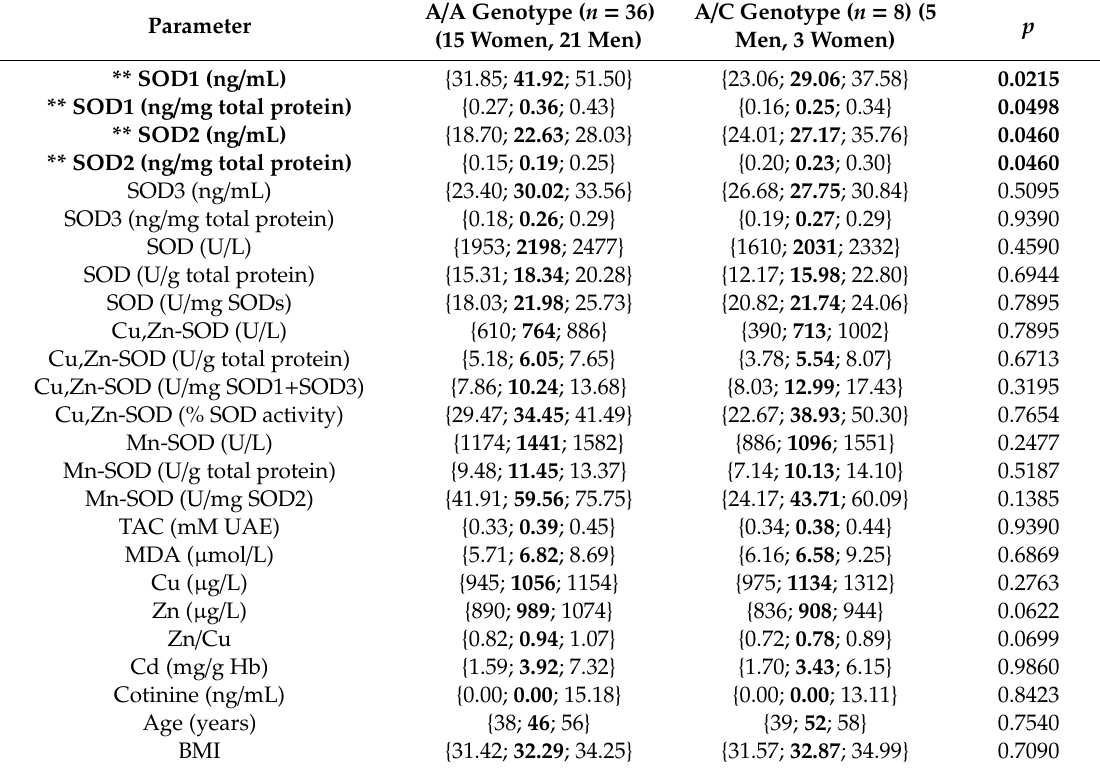
Table 10. Values of selected pro- and antioxidative parameters, and concentration of selected metals, in context of genotypic variability of rs2234694 ( SOD1 ), in obese